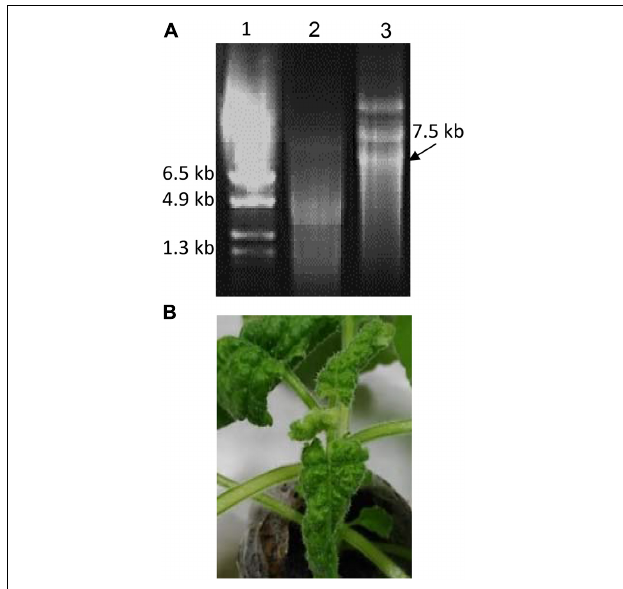
FIGURE 2 | Production of infectious RNA from TMV-PSN-NPC2 clone and inoculation of N. benthamiana plants (A) In vitro transcription (IVT), ethidium bromide-stained 0.5% agarose gel. 1: RNA marker (Promega G319A), 2: RNA control kit, 3: RNA TMVPSN-NPC2. The RNA transcribed (7.5 kb) was used for plant inoculation. (B) Infectivity of the recombinant virus. The picture shows a plant at 8 dpi (days post inoculation). Leaves with symptoms of infection reflected by the mild leaf deformation with variable mottling